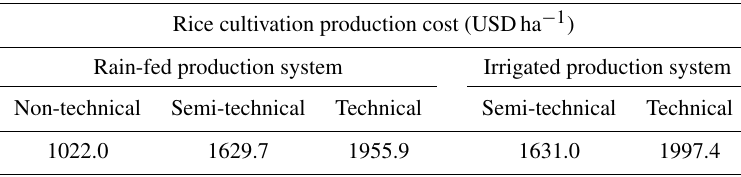
Table 1. Official production cost of different rice-production systems in Ecuador in 2017.